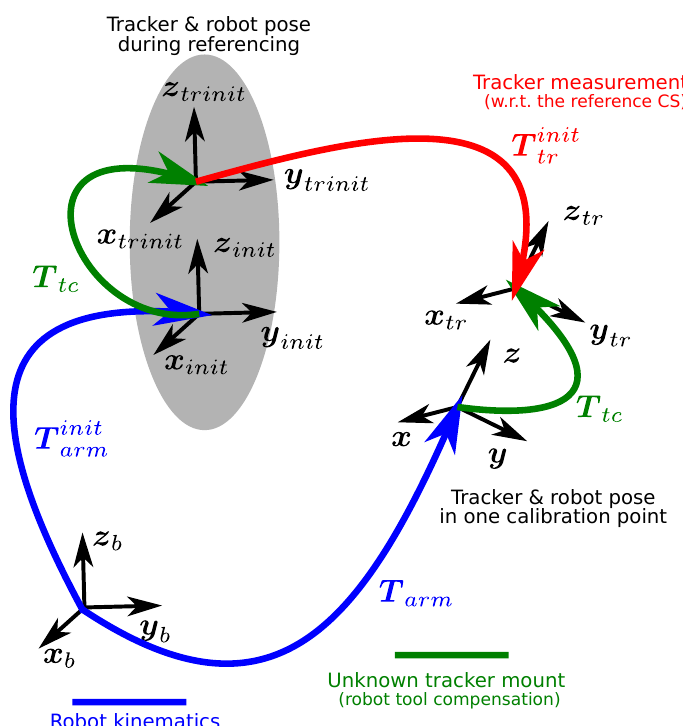
Figure 6. Tracking device calibration—kinematic diagram of one measurement